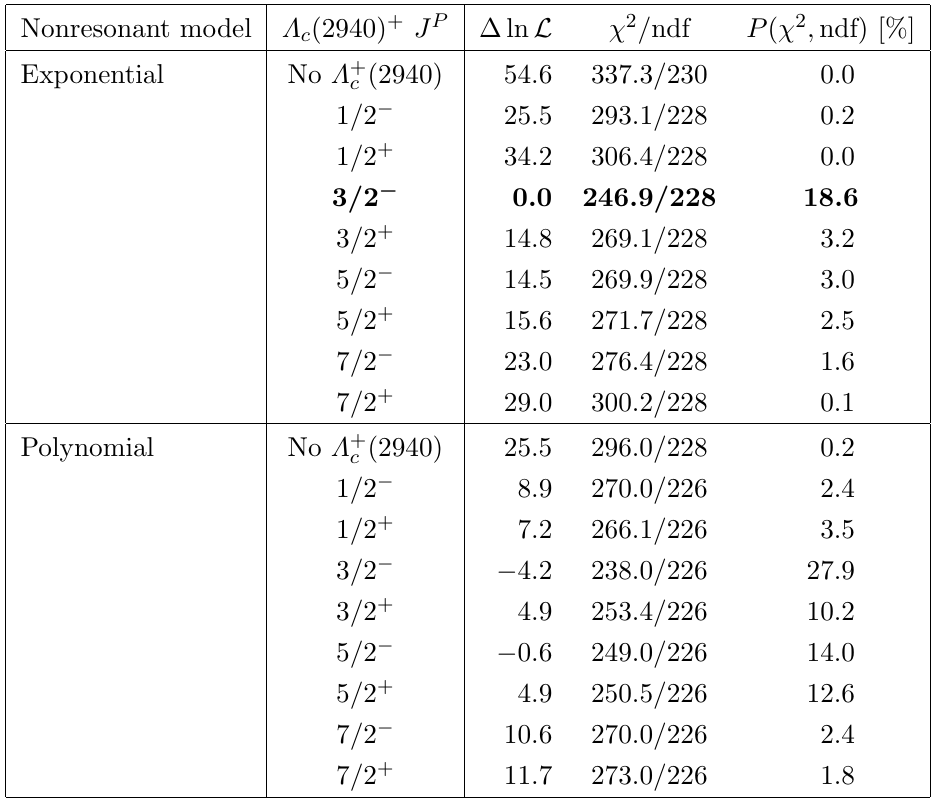
Table 8 . Fit quality for various (cid:3) c (2940) + spin-parity assignments. Exponential and polynomial parametrisations of the nonresonant lineshapes are considered. The baseline model is shown in bold